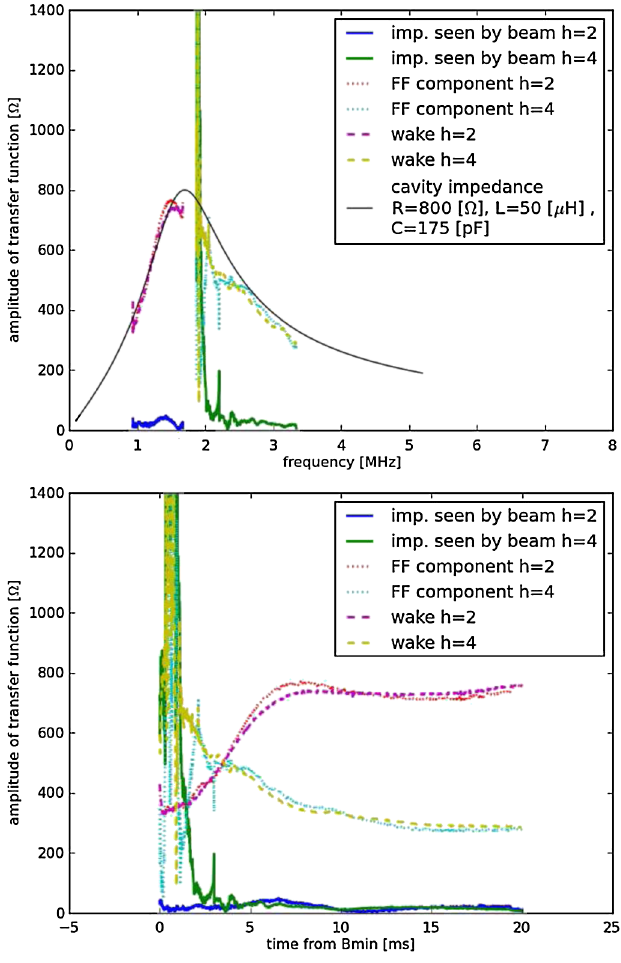
FIG. 23. Cavity #11 impedance seen by the 400 kW equivalent beam with the feedforward parameters optimized by the 300 kW equivalent beam—(top) frequency domain and (bottom) as a function of